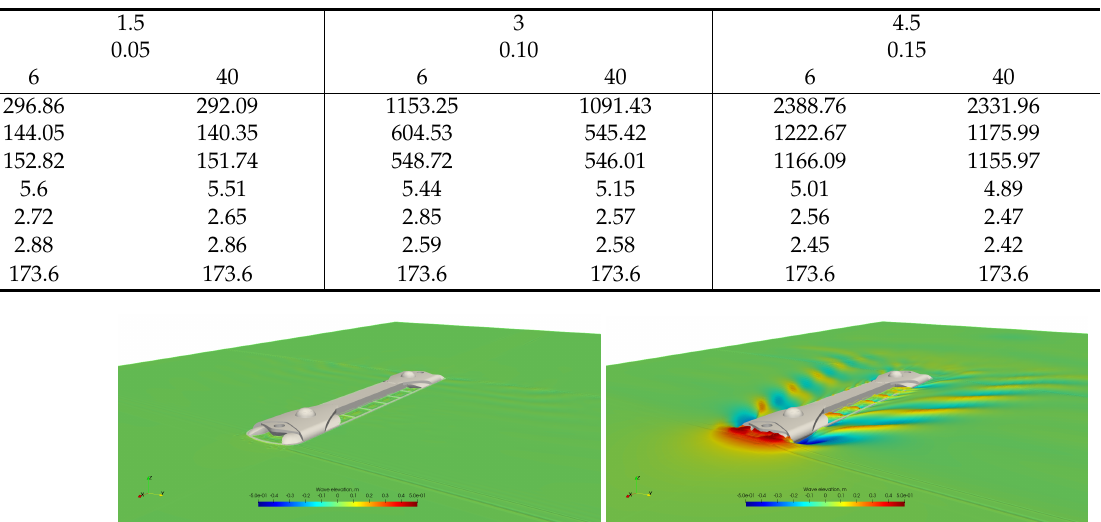
Figure 13. Free surface elevation at 1.5 and 6 knots for Geometry 3 sailing at the free